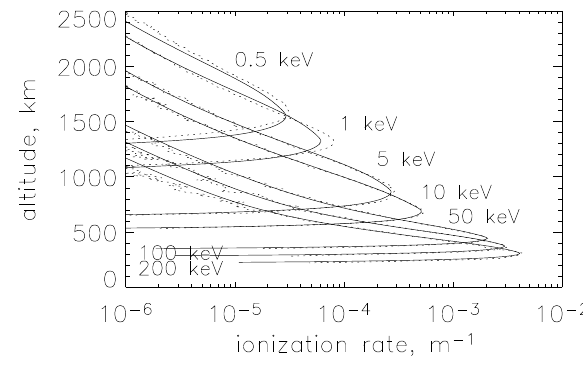
Figure 5: 2007.12.18: Y. Hiraki and C. Tao Fig. 5. Shown are parameterized q ion values (solid), and are com- pared with the calculated ones (dotted) in Fig.